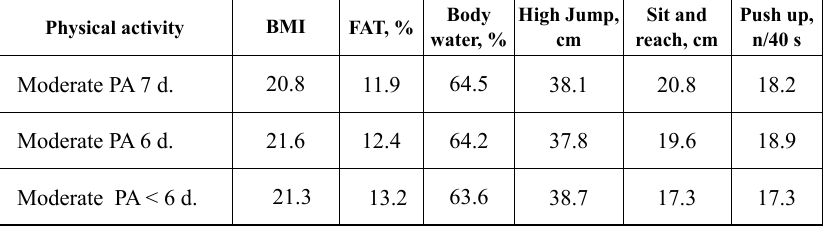
Table 2. Health-related physical fit- ness of the adolescent boys who